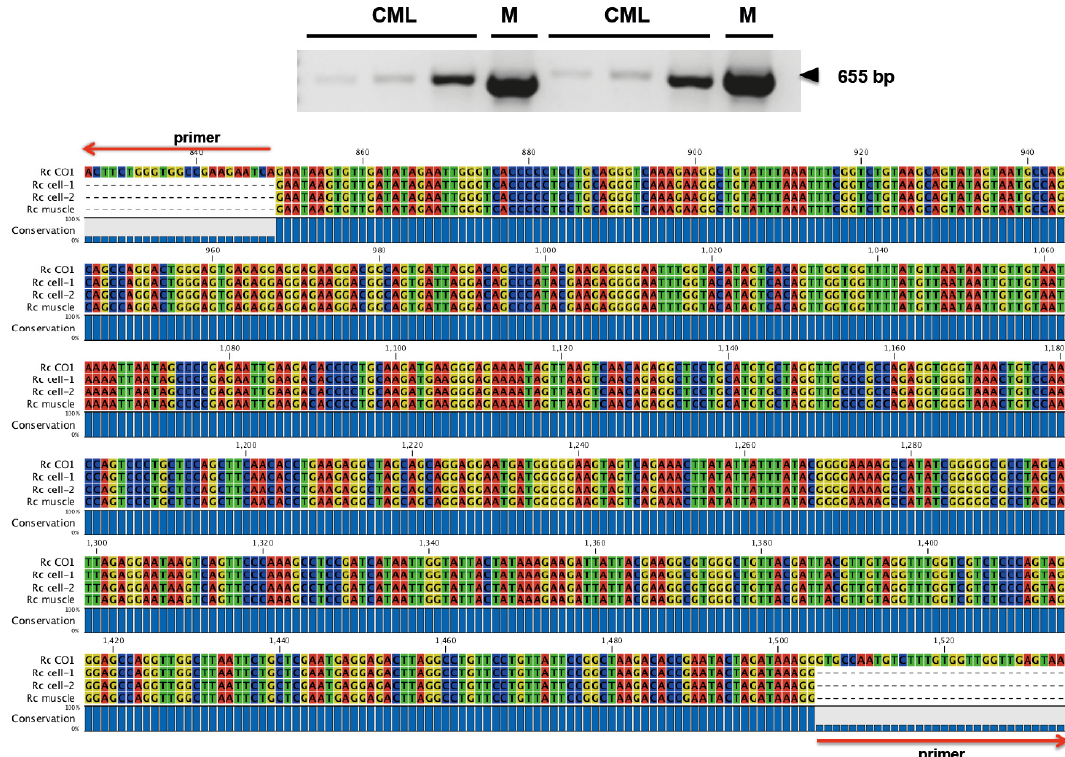
Figure 2. Identification of cobia cell origin: The upper panel shows PCR-amplified DNA from cobia muscle cell line (Cm) and cobia muscle (M) using primer pairs specific for cobia cytochrome oxidase subunit 1 (COI) gene and primers specified in Supplemental Table S1. Amplicons were fractionated by 1% agarose gel electrophoresis. The lower panel shows a multiple alignment of amplified COI DNA sequences from Cm cells and a cobia muscle sample compared with the cobia cytochrome oxidase subunit 1 (COI) reference sequence (GenBank accession # KJ202194.1) using the ClustalW program. The red arrows indicate the primer position.